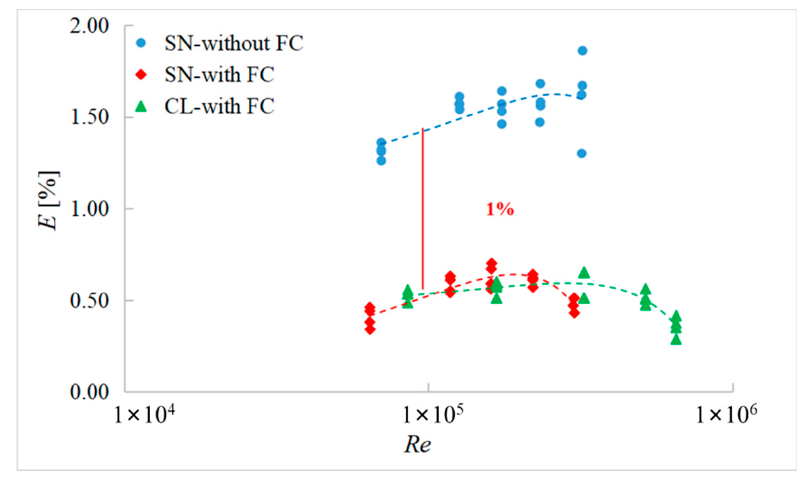
Figure 6. Results with different installation conditions at 0.36 MPa.